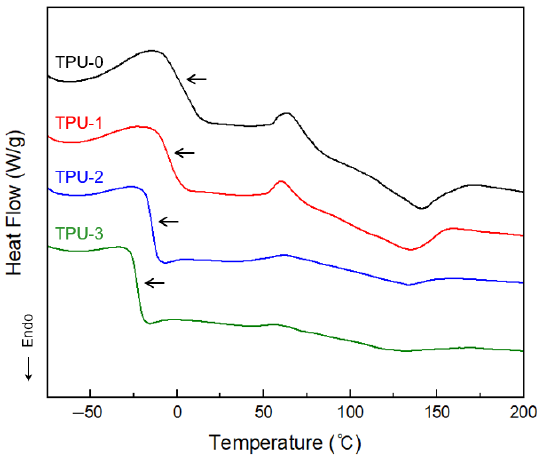
Figure 2. DSC thermograms of synthesized TPU samples. Table 3. DSC characterization studies of the synthesized TPU samples.